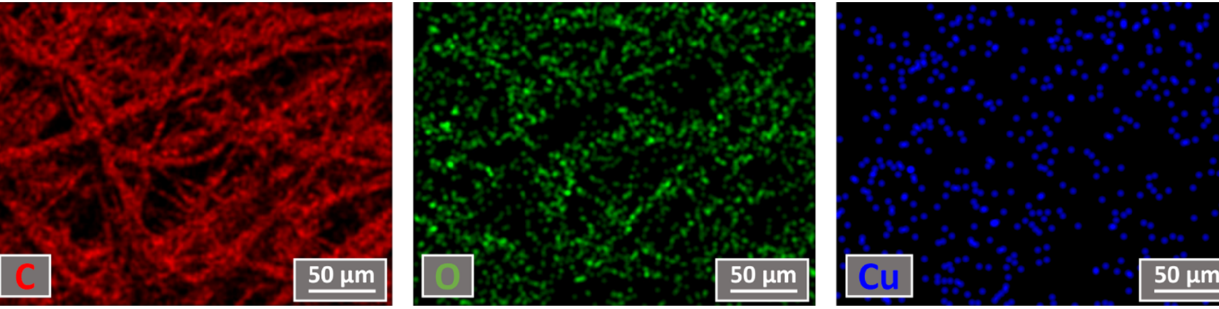
Figure 5. Elemental mapping views of samples deposited for 120 min.